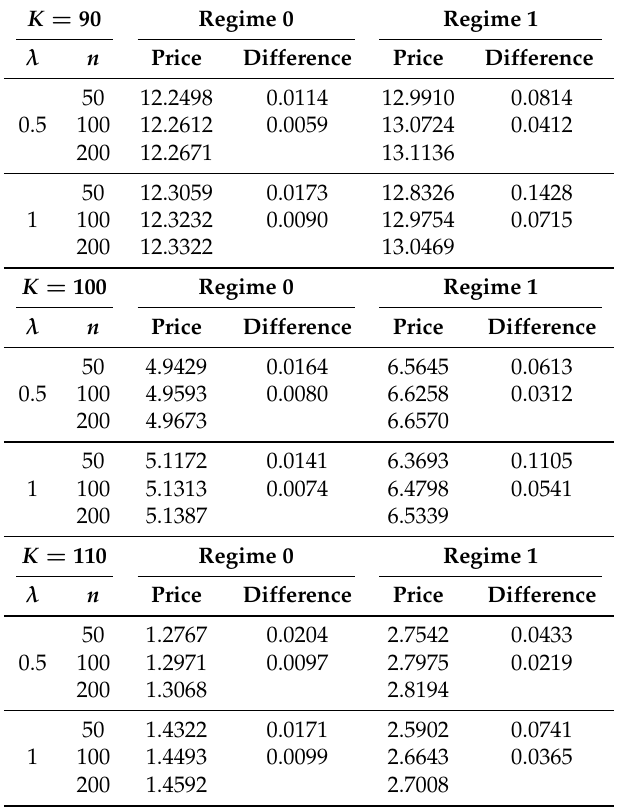
Table 4. Numerical convergence in a two-regime economy with a 0,1 = a 1,0 = λ (1/year). K = 90 Regime 0 Regime 1 n